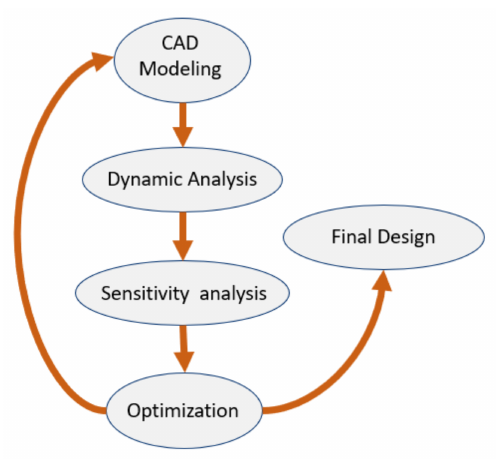
Figure 2. Schematic for overall process of exoskeleton